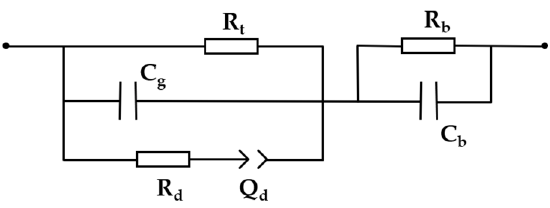
Figure 12. Equivalent electrical circuit used for fitting the impedance data.